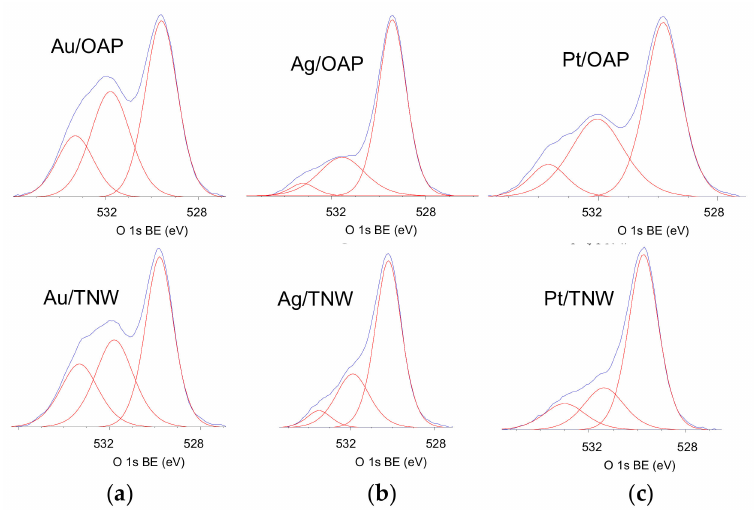
Figure 6. XPS results for O 1s for NM-modified samples: OAP (top) and TNW (bottom) for: ( a ) Au, ( b ) Ag and ( c ) Pt.